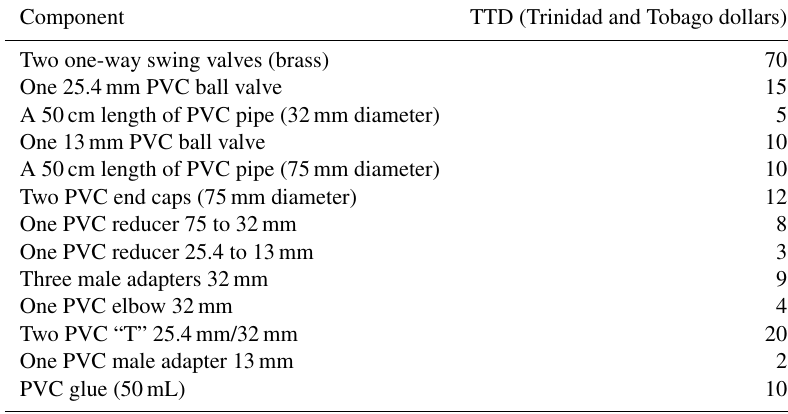
Table 1. Cost of the pump components.